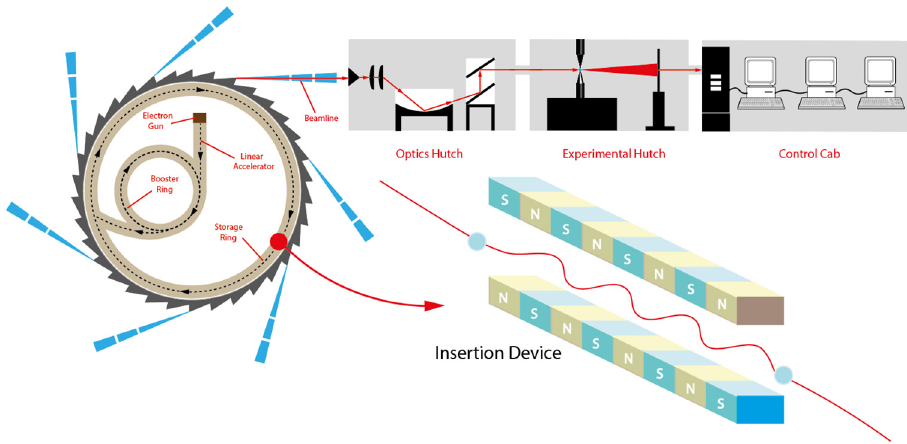
Figure 3. Schematic of synchrotron facility.